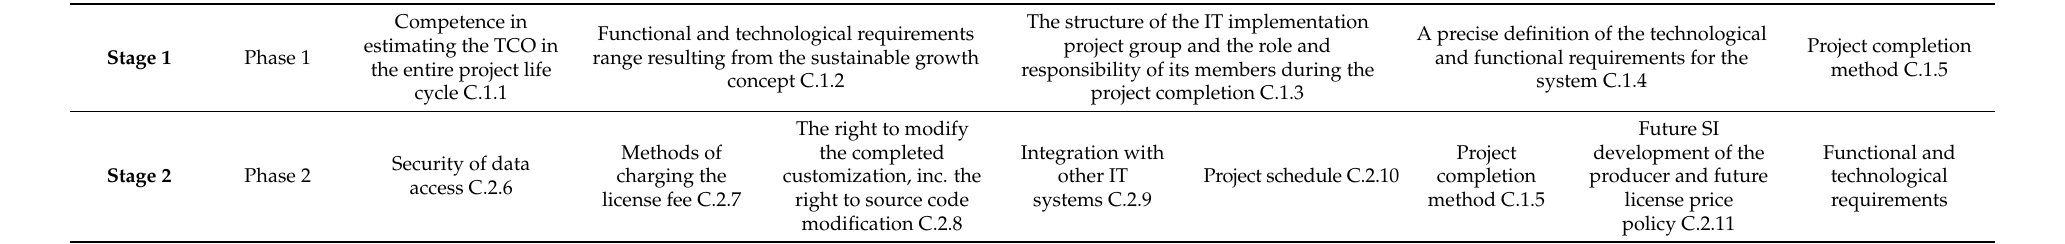
Table 3. The structure of information components on the client’s side during Stage 1 of the IT implementation projects. Source: Own study.